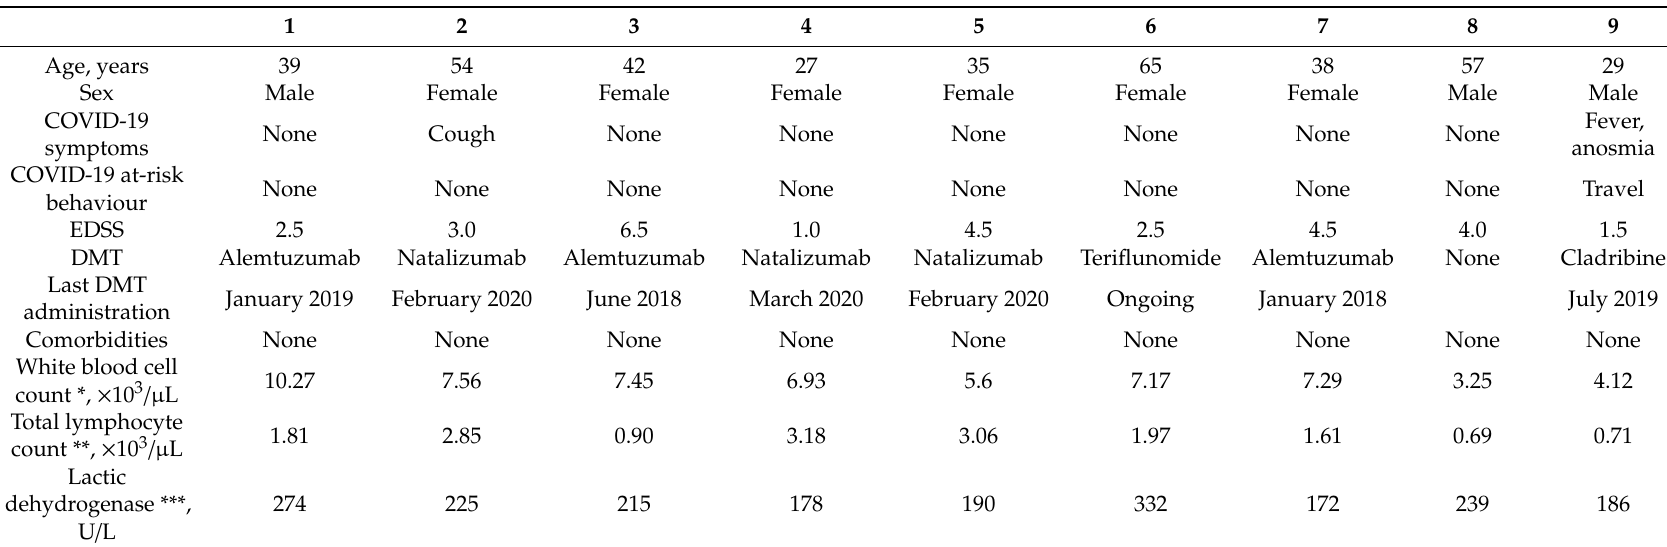
Table 3. Demographics, clinical features, treatments, and laboratory findings of MS patients positive to SARS-CoV-2 IgG / IgM in May–June 2020. 1 2 3 Age, years Sex